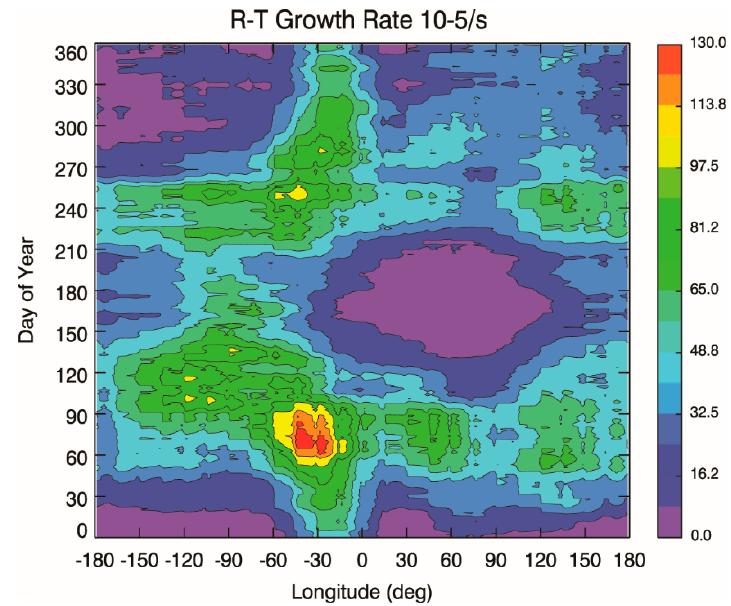
Figure 5. Seasonal and longitudinal variations of the Rayleigh–Taylor instability growth rate at 270 km during the year of 2006 (Figure 2a in Wu [25]).